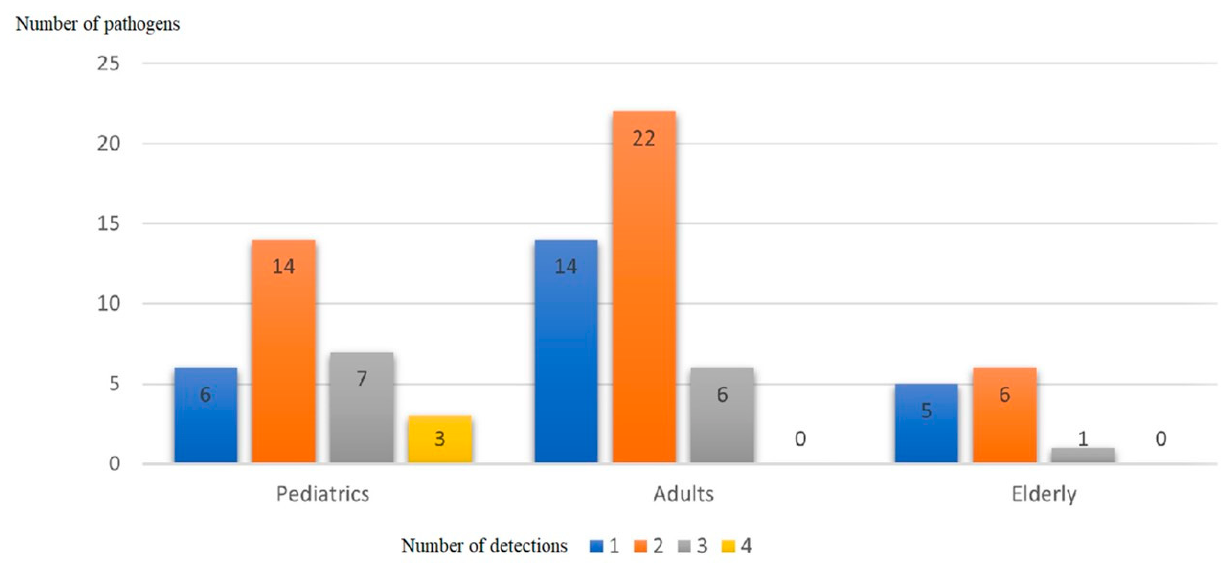
Figure 3. Number of pathogens detected in different age groups.